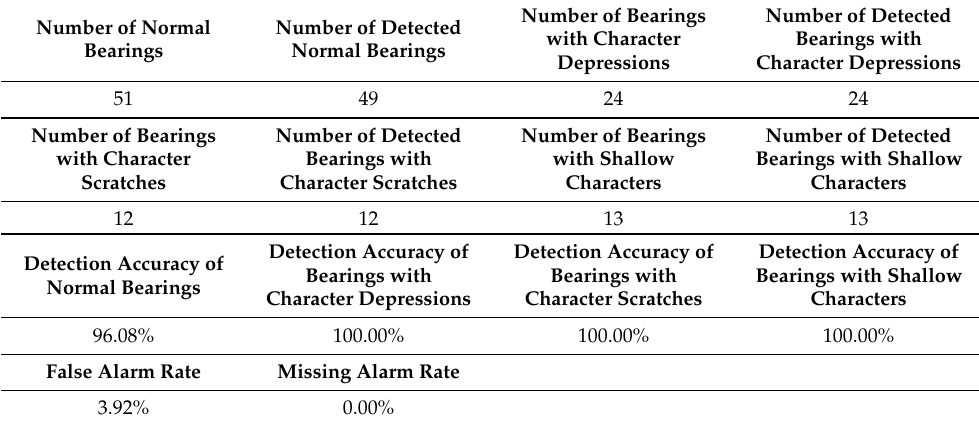
Table 5. Detection results of character depressions, character scratches, and shallow